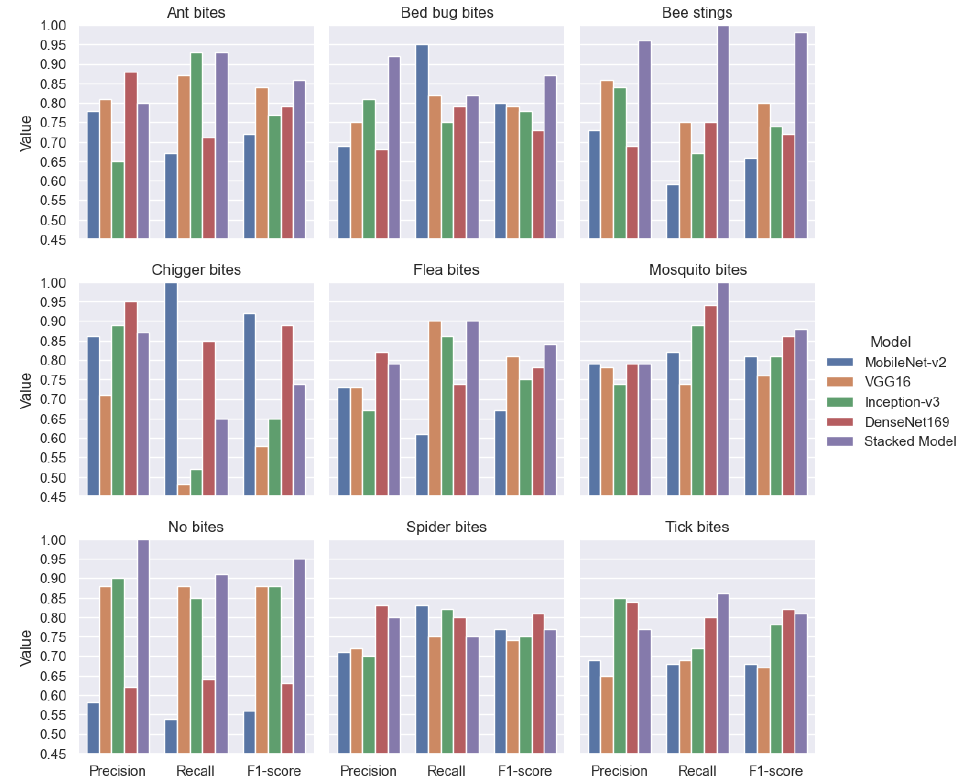
Figure 18. Model performance for each class. Evaluation metrics: precision, recall and F1-score. Each of the nine graphs refers to each of the classes in the